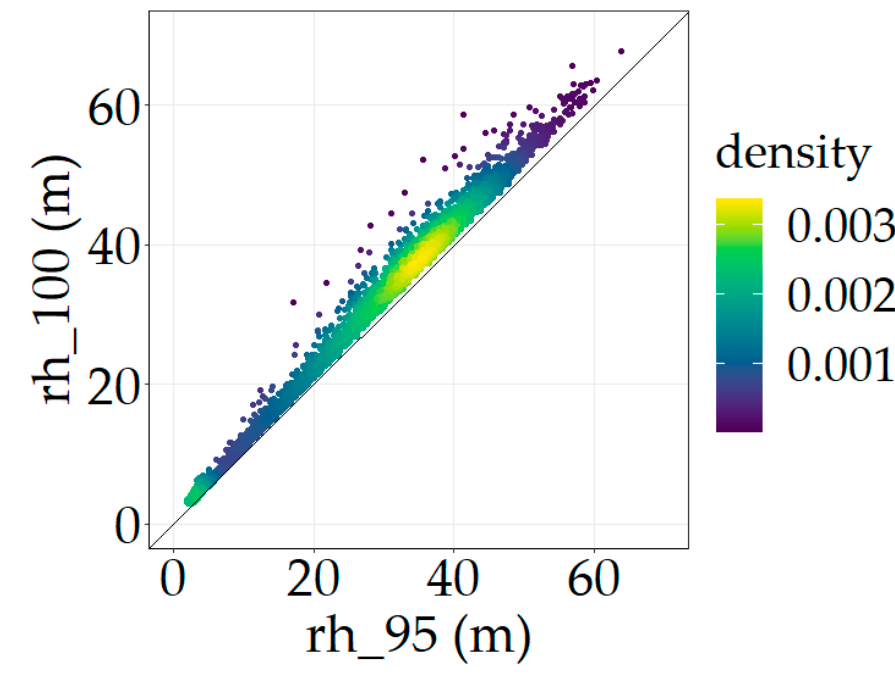
Figure 3. Correlation between GEDI relative heights of percentiles 95 and 100 (R 2 = 0.99).